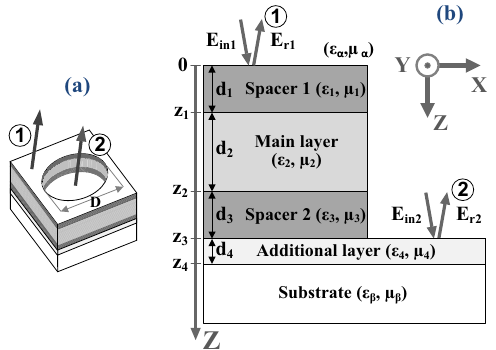
Fig. 1. (a) Scheme of the multilayer with the microhole that can be obtained with the laser ablation method (one of the pixels in the case of the phase-only binary nanohologram). The rays re fl ected from the multilayer are denoted by numbers 1 and 2 (the incident wave is not shown). D is the hole diameter. (b) Geometry of the corresponding electromagnetic boundary problems. The multilayer includes additional (protective, spacer) “ conventional ” layers and the main layer and optically thick substrate which electromagnetic properties can correspond to ENZ MMs. E in1,2 and E r1,2 are the fi elds of the incident and re fl ected